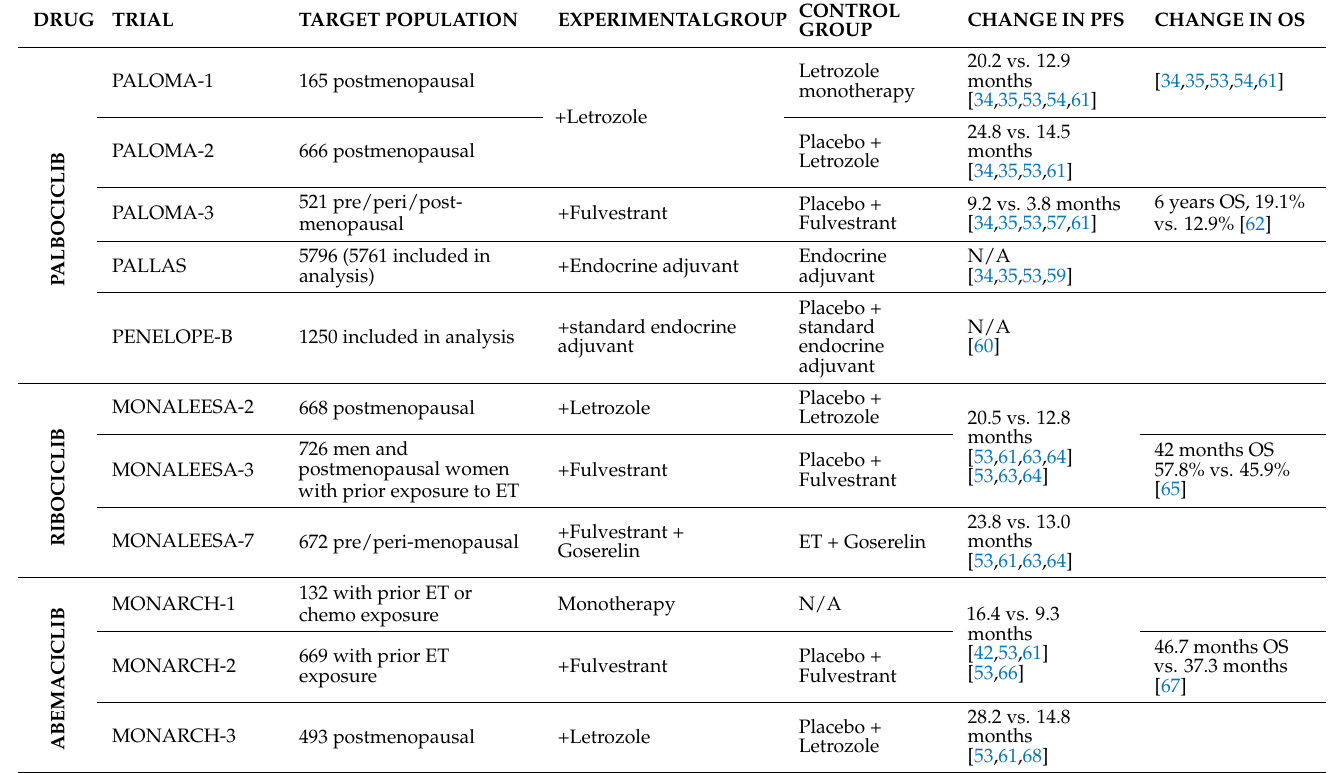
Table 2. Summary of CDK4/6 Inhibitors and Corresponding Research